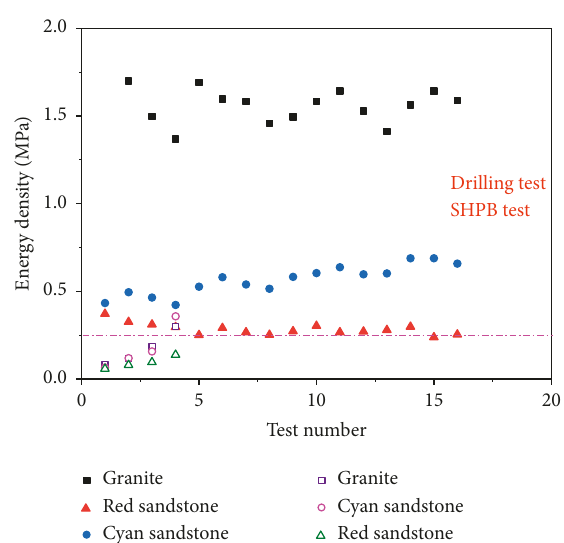
Figure 16: The scatters of the MSE and the energy density of the drilling and SHPB